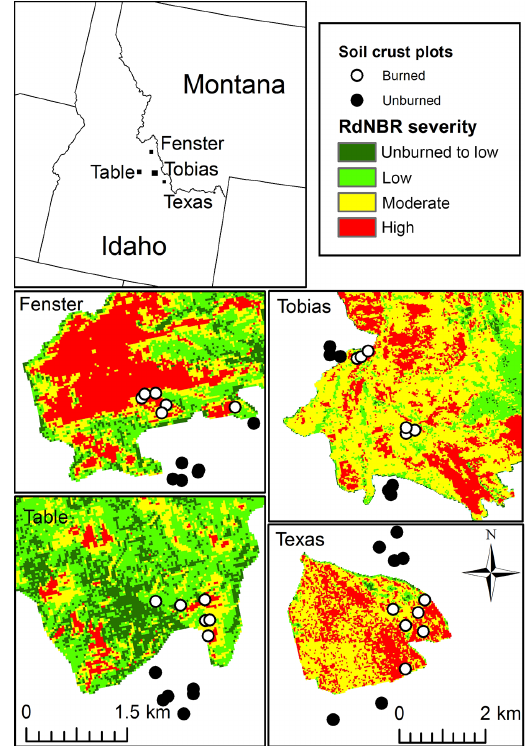
Figure 1. Study sites in Idaho, USA. Each of the four historic fires served as a site with six plots inside and six plots outside of the fire perimeter. Shading represents fire severity as measured by RdNBR following categorizations by Reilly et al.